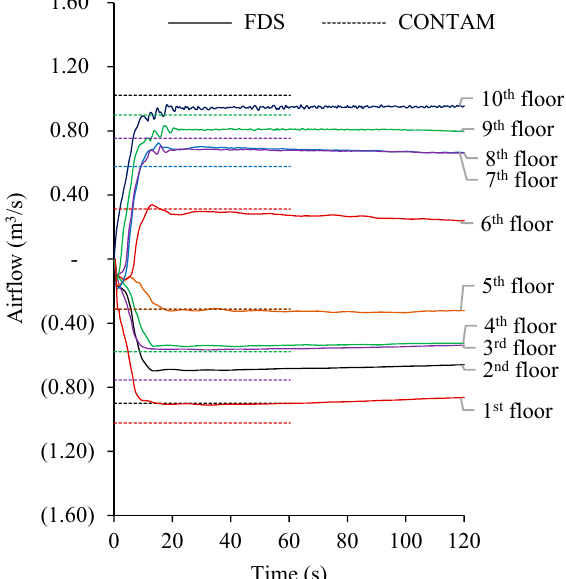
Figure 14. Airflow simulation of open stair doors and a very leaky envelope measured at A 1 utilizing the physical opening method.